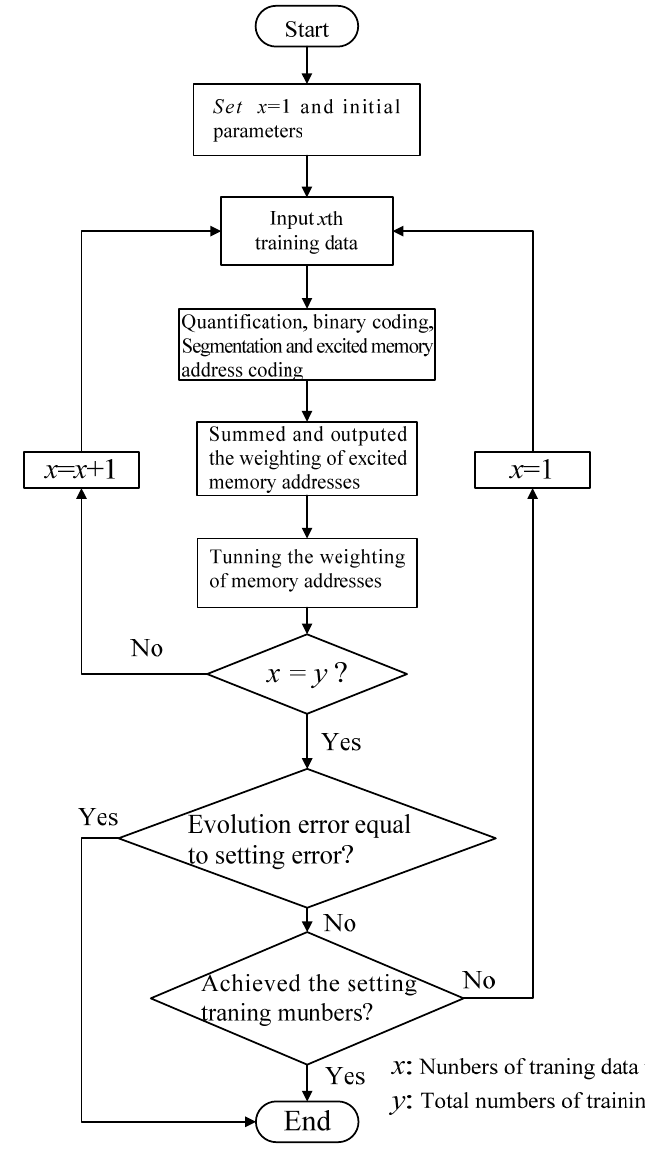
Figure 3. Flowchart of the islanding detection training process for CMAC neural